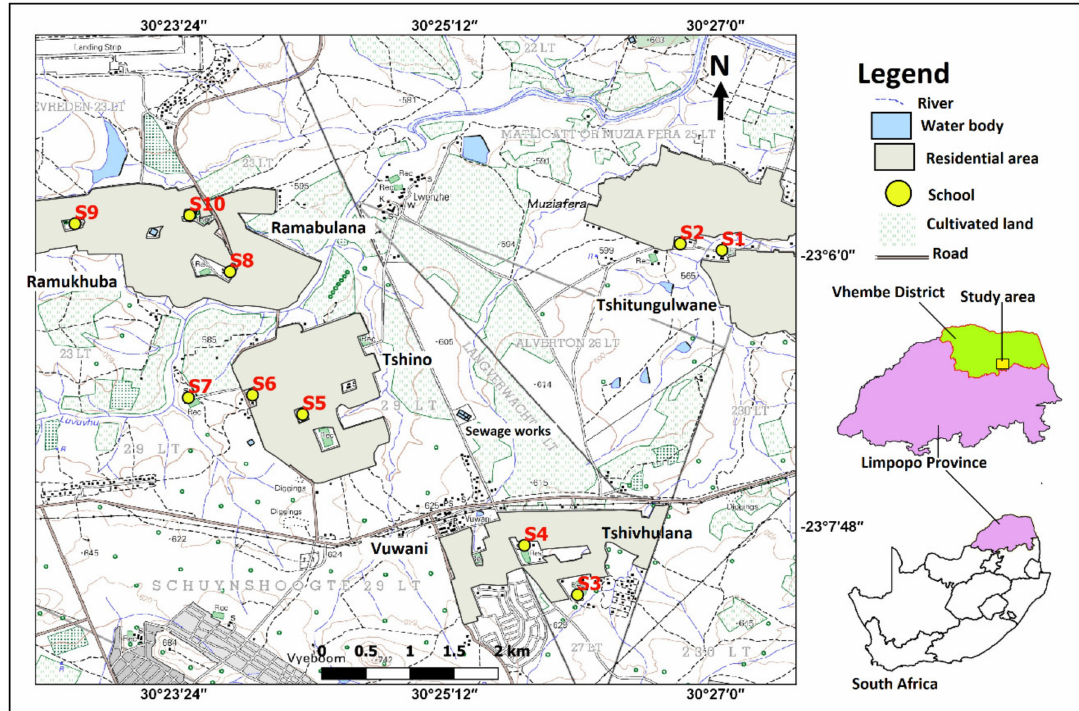
Figure 1. Location of the study